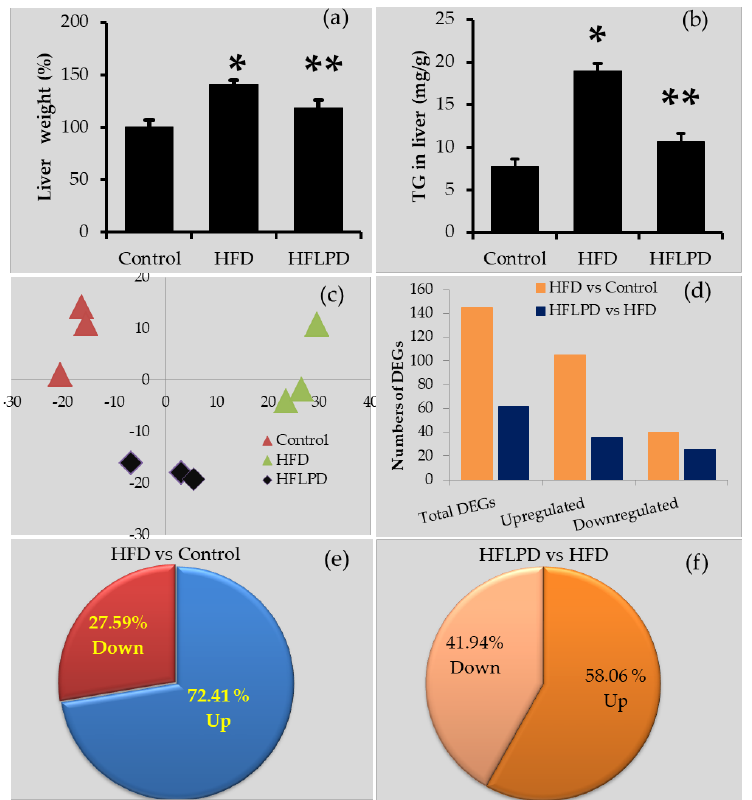
Figure 1. The total liver weight, triglyceride content, and the number of differentially expressed genes (DEGs) in the liver of experimental animals. ( a ) Total weight of liver tissues of experimental animals, ( b ) triglyceride content of liver tissues of experimental animals. These data are represented by the mean ± standard deviation, total liver weight ( n = 5), and TG content ( n = 3 ). * p < 0.05 HFD vs. Control; ** p < 0.05 HFLPD vs. HFD. ( c ) Principal component analysis (PCA) of each group, ( d ) total number of DEGs in the liver tissues of HFD- and HFLPD-fed mice ( p < 0.05, greater than 2-fold), ( e ) percentage of up- and downregulated DEGs in the liver tissue of HFD vs. Control, ( f ) percentage of up and downregulated DEGs in the liver tissue of HFLPD vs. HFD.